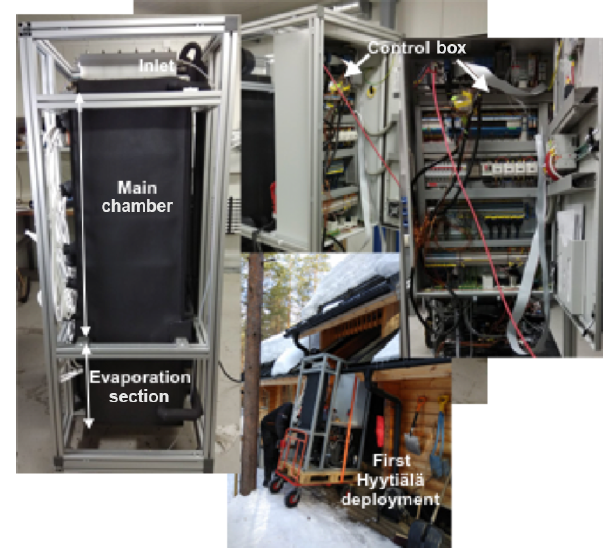
Figure 2. Images of the PINCii instrument with the main ice-coated flow reactor chamber, evaporation sections, and electronic control box indicated. The instrument was first deployed for field testing during the 2018 Hyytiälä HyICE measurement